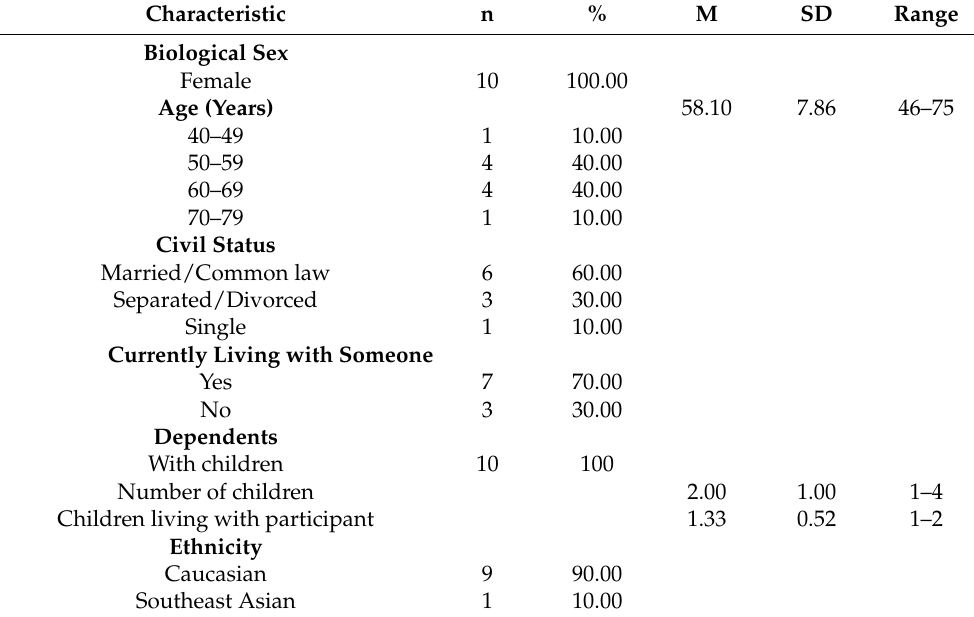
Table 1. Participant